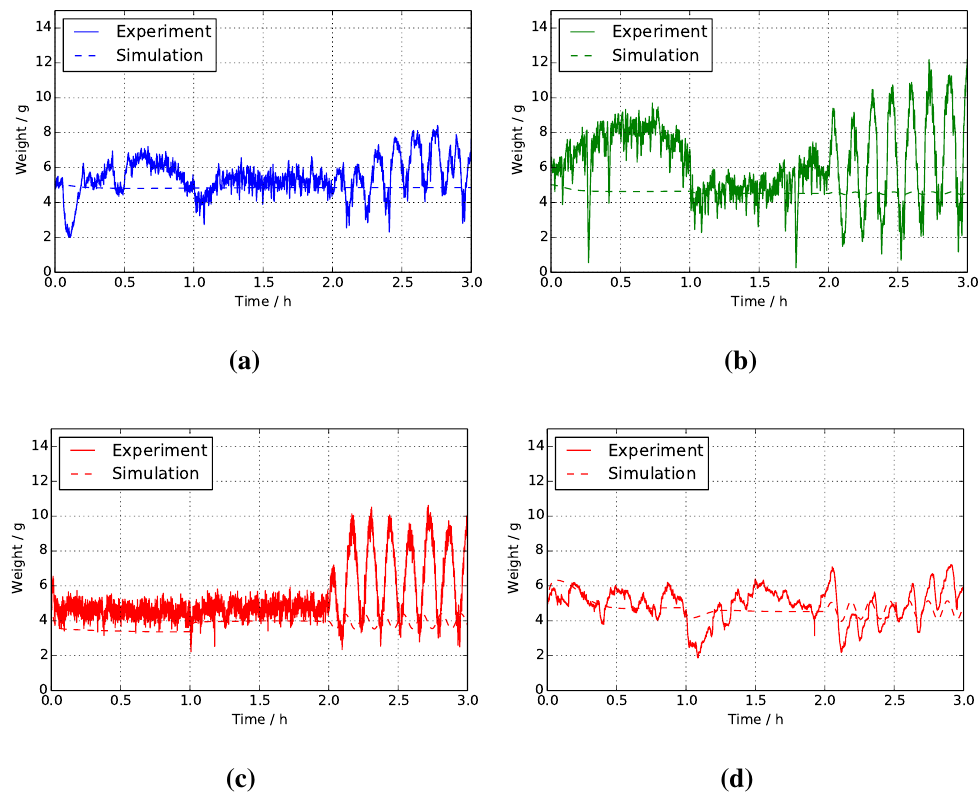
Figure 10. Solution weight during the operation of the mixer in the various systems and the weight of the water tank in the separate tank system. ( a ) Reference; ( b ) two-mixer; ( c ) separate tanks, solution; ( d ) separate tanks, water.